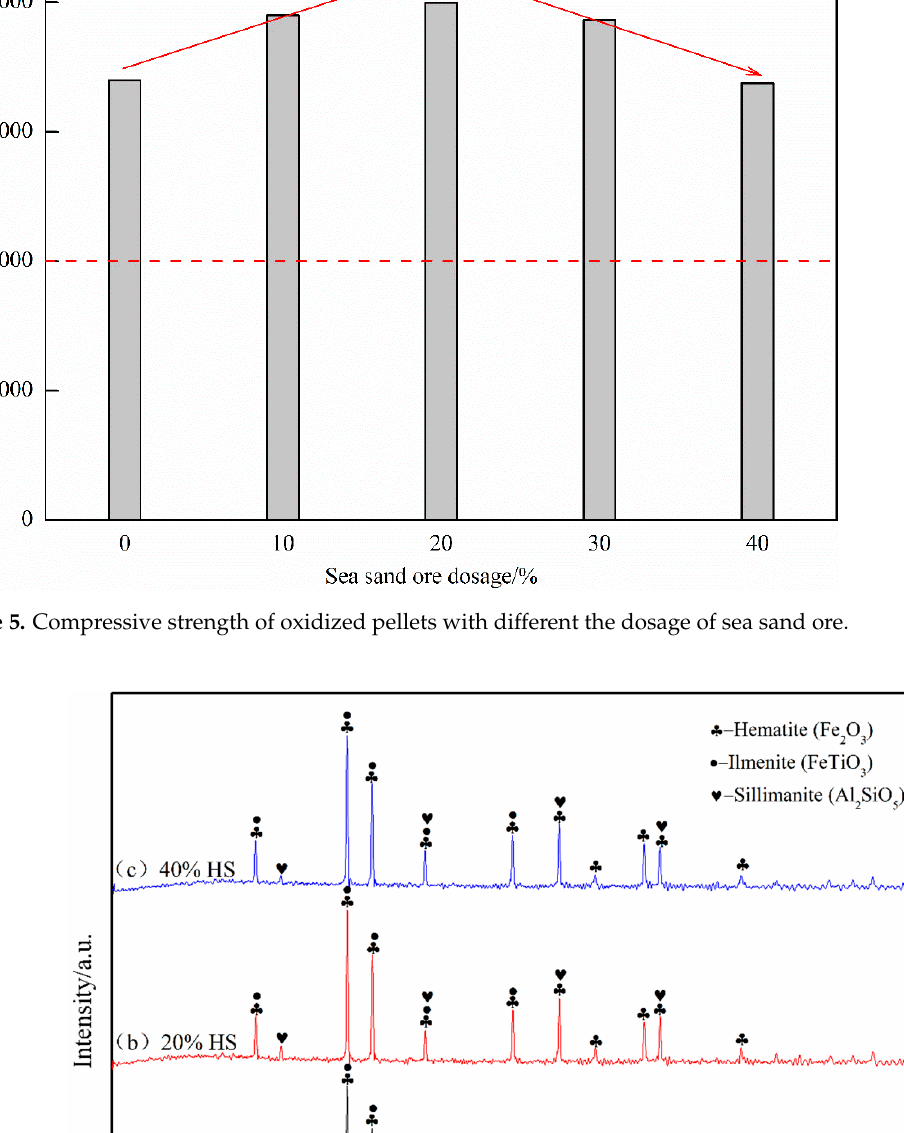
Figure 6. X-ray diffraction analysis of oxidized pellets with different the dosage of sea sand